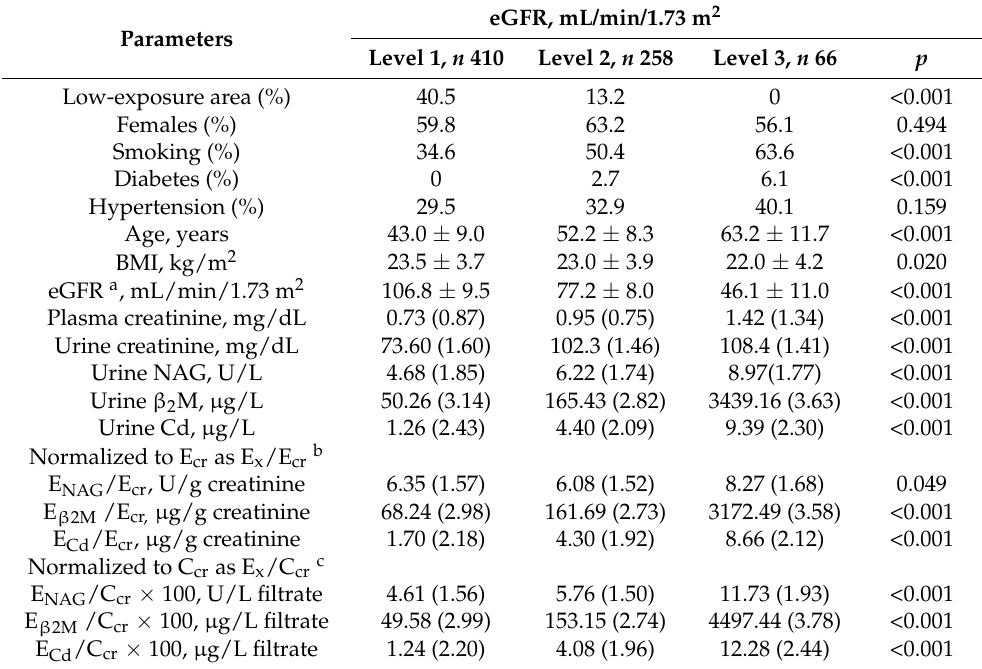
Table 2. Characteristics of the study subjects stratified by eGFR values.